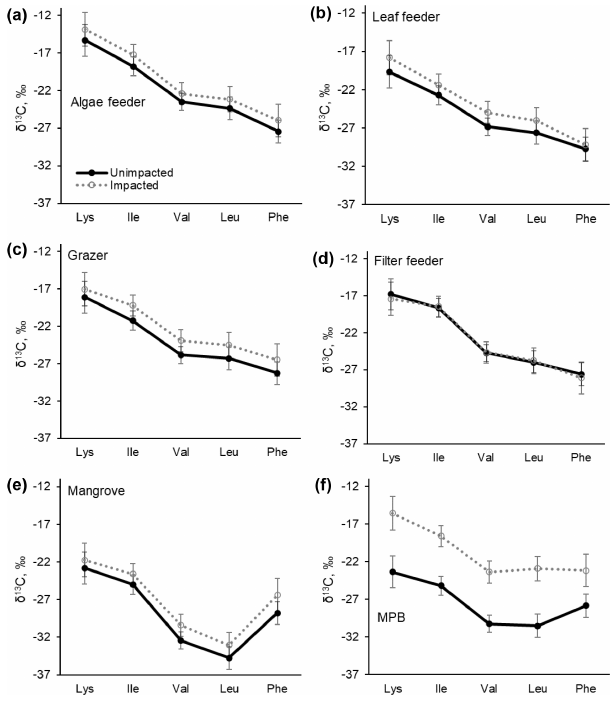
Figure 6. C isotopic compositions in essential amino acids (EAAs) for four mangrove consumer groups and resources including man- grove leaves ( A. marina ) and MPB from the unimpacted and im- pacted mangrove sites during 2017 (20 months after the dieback). While there are clear offsets in individual δ 13 C EAA values be- tween the two forests, normalised δ 13 C EAA fingerprint patterns as per Larsen (2009) shown in Fig. S1 did not differ (PERMANOVA p > 0 . 05, Table 3). Error bars show ± SD. The data are provided in Table